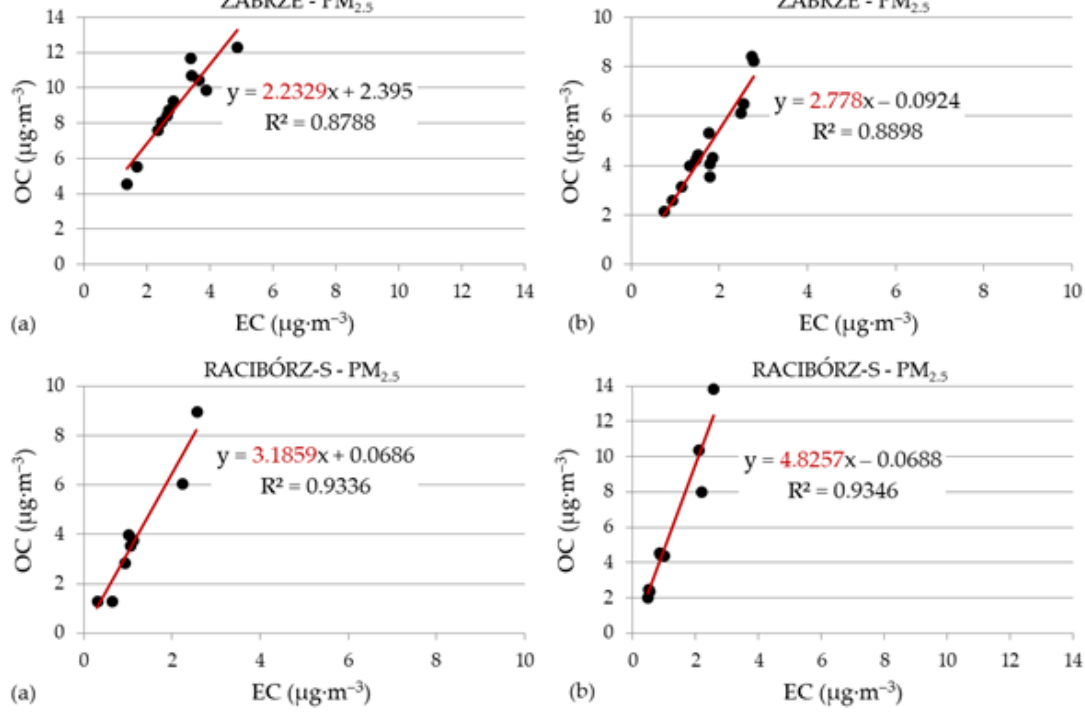
Figure 2. Linear relationship between OC and EC, taking into account 10% of the samples with the lowest values of the OC/EC ratio (measurement sites in Zabrze (PM 2.5 ) and Racibórz-S (PM 2.5 )). ( a ) heating season; ( b ) non-heating season.